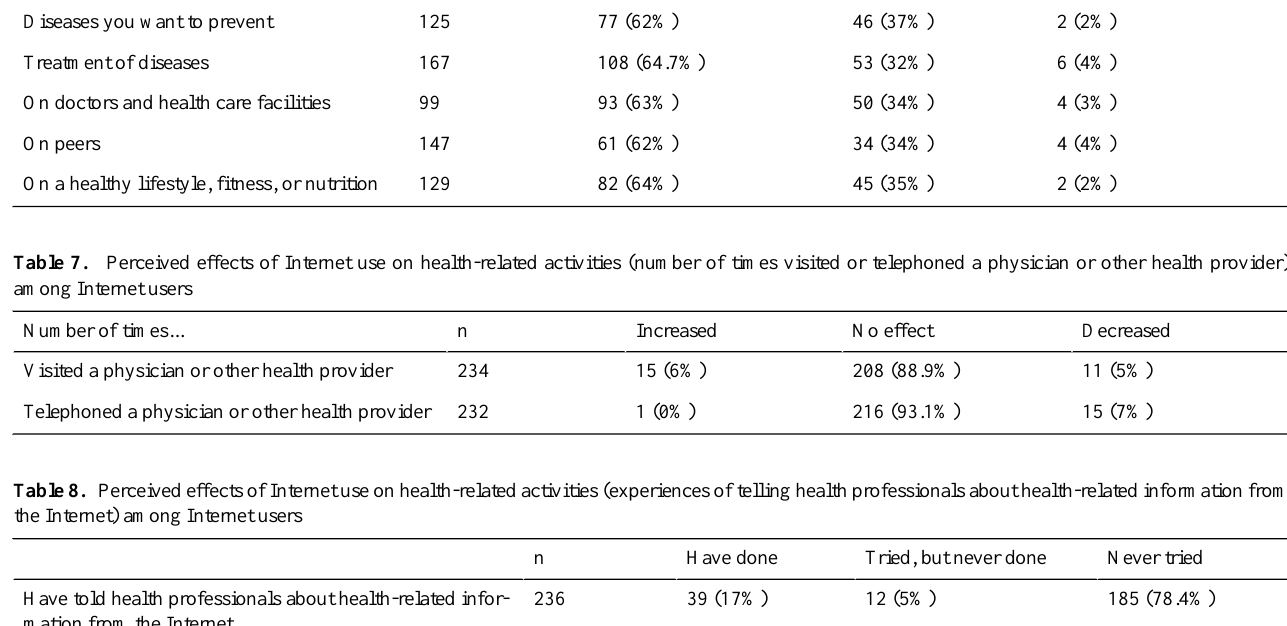
Feeling anxiousNo effectFeeling confidentnFeeling after obtaining information on...